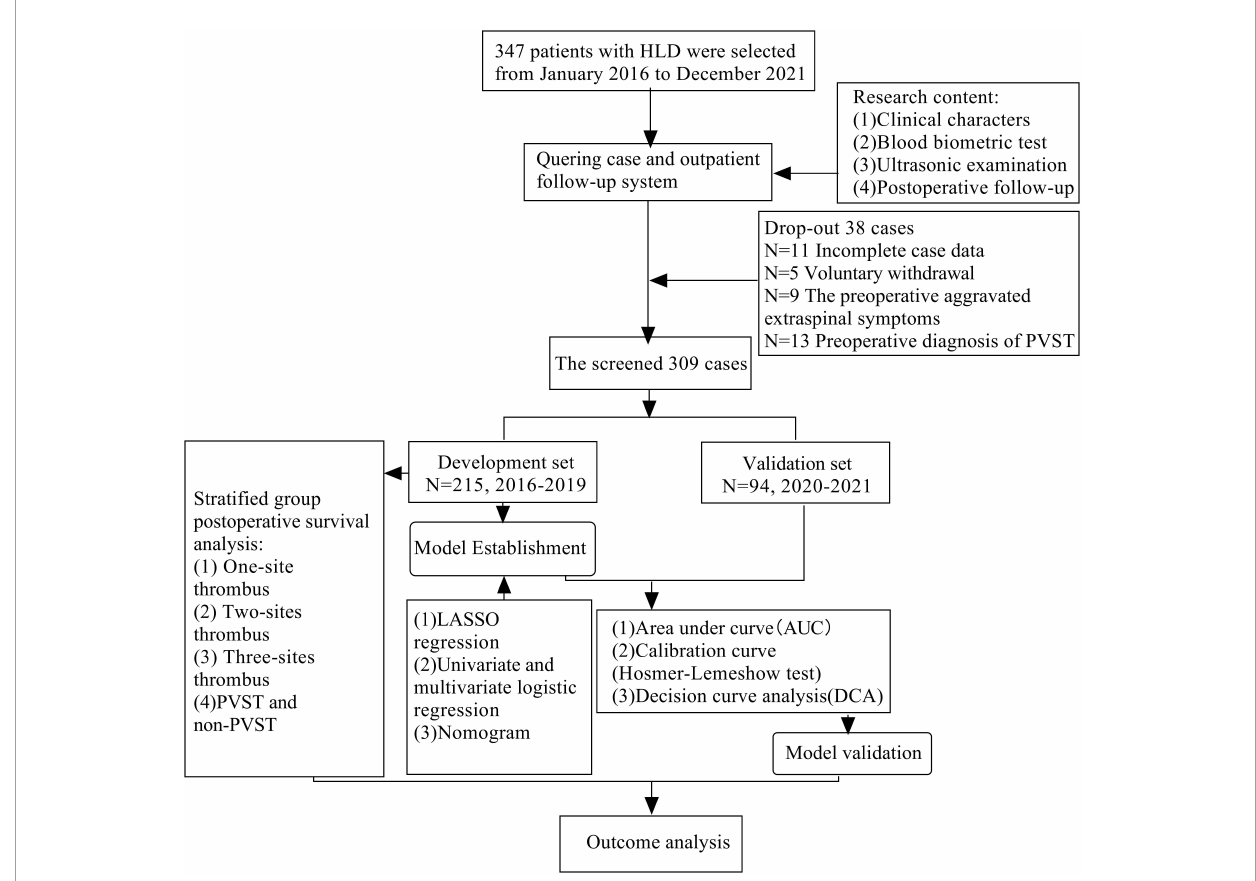
FIGURE2 Flow chart of selection and analysis of development set and validation set of HLD patients.